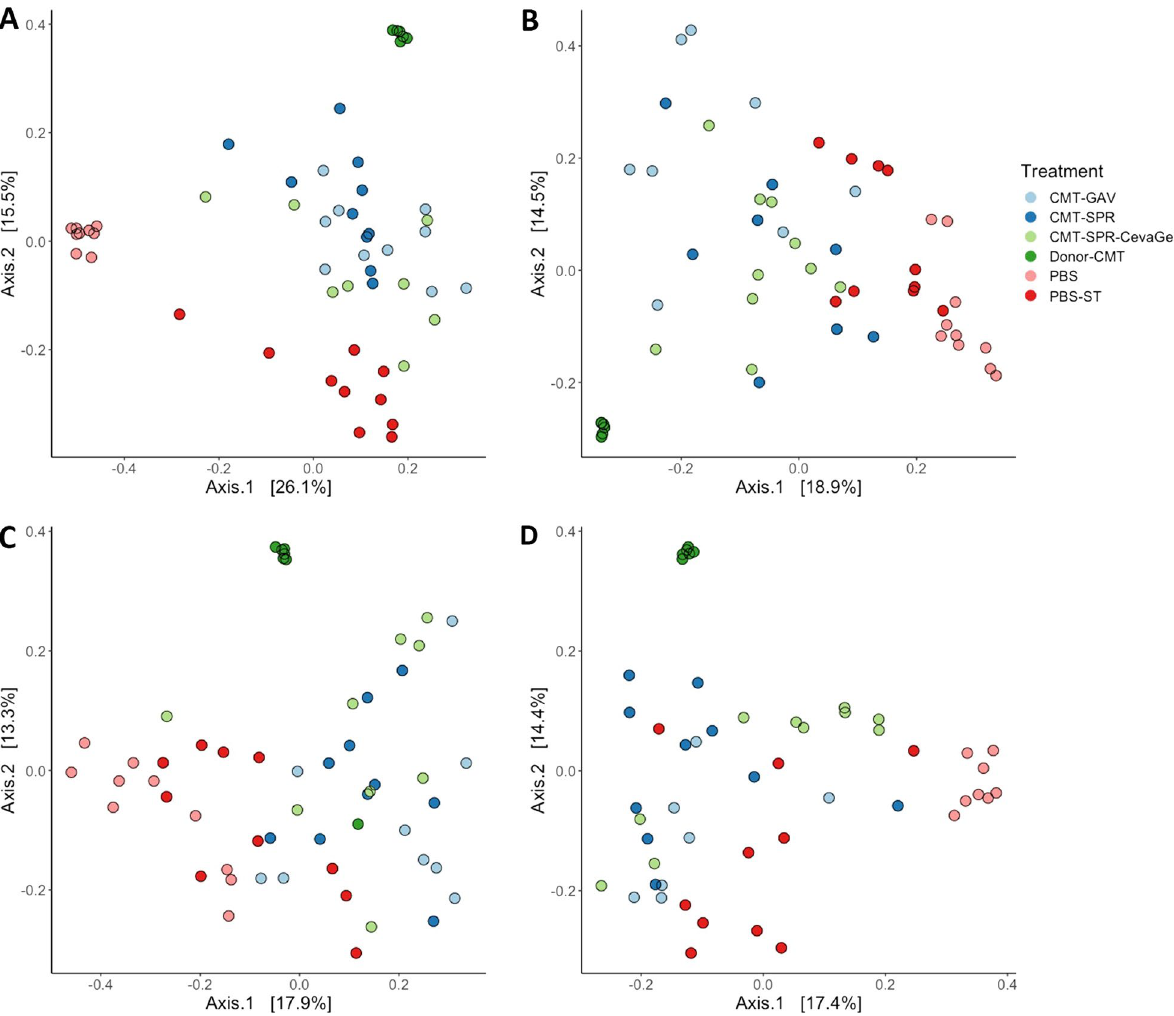
Fig. 7 Effect of route on patterns of community composition in CMT birds compared to PBS birds. Principle coordinate of Bray-Curits dissimilarity plots show differences between the composition of CMT groups compared to PBS groups, though not as distinct as in the timing experiment. At 7-dph the distinction between the CMT and PBS groups was most clear with the CMT groups appearing to cluster more closely with the donor CMT than the PBS groups ( A ). Similar shifts appear to occur with the PBS-ST group at 3-dpi ( B ) as occurred in the timing experiment with the PBS-ST group developing a composition like that of the CMT groups compared to PBS groups. By 7-dpi ( C ) and 14-dpi ( D ) more of the PBS-ST groups cluster with the CMT groups than the PBS